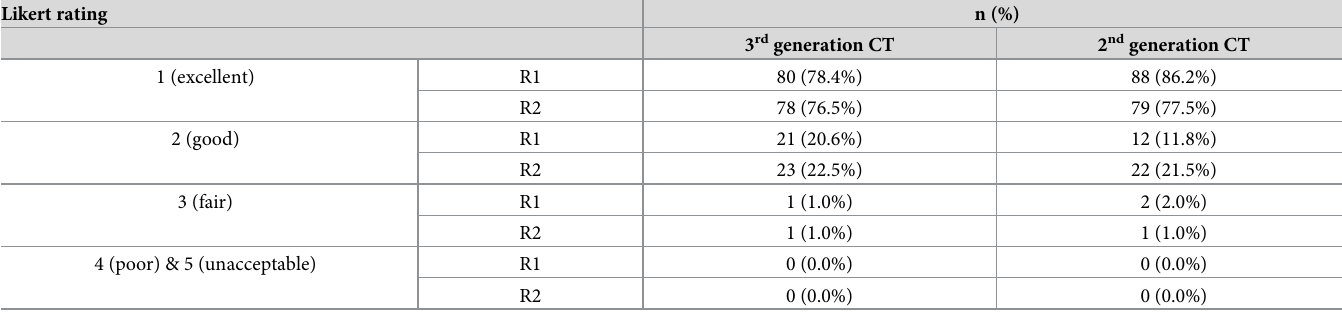
Table 6. Frequencies of Likert rating per group.